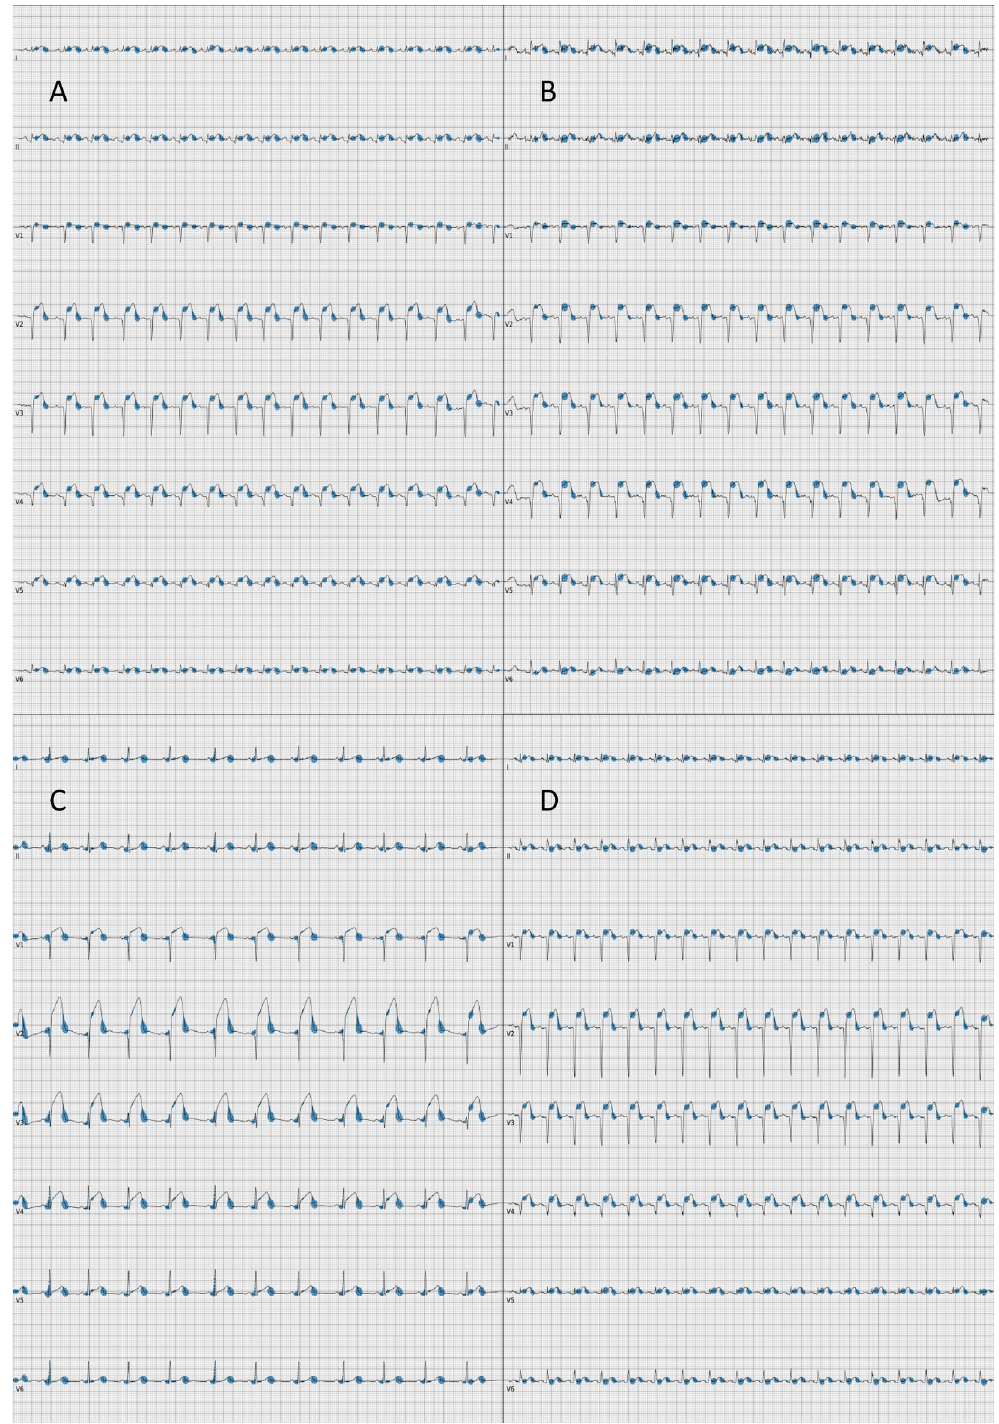
Figure 2. Four representative STEMIs correctly classified with high probability. Four Grad-CAM plots of STEMIs correctly classified with high probability, highlighting the parts in the ECG that the model focuses on for its prediction. Gradients corresponding to the activations in the first convolutional layer of the neural network are averaged to get the proportional importance of each channel, which is then used to compute a proportional mean of the activations. Positive values obtained were plotted as blue disks overlaid on top of the ECG, with size proportional to its